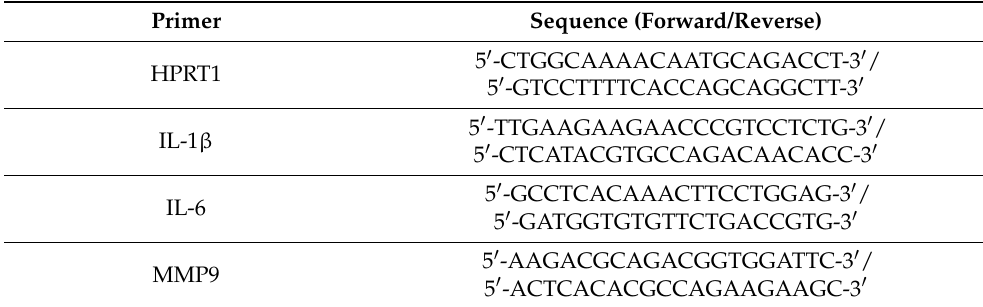
Table 2. Sequences of the different primers analyzed by quantitative polymerase chain